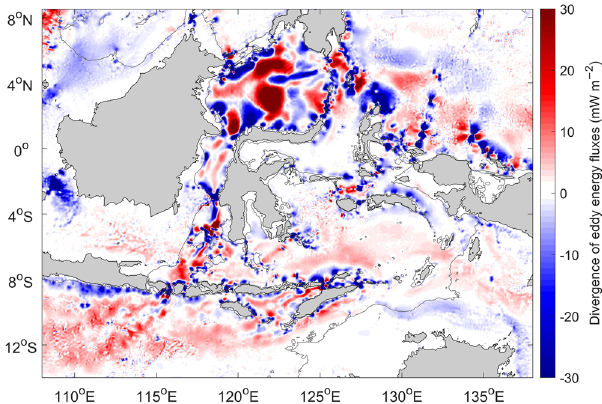
Fig.3|Divergenceoftime-averaged,vertically-integratededdyenergy fl uxesin (mWm − 2 ; 1mWm − 2 =10 − 3 Wm − 2 ). Red and blue correspond to energy sources (positive) and sinks (negative). The color scale is saturated to show regions of relatively weak eddy energy sources in the interior. 200m isobath is shown by the thin gray contour.